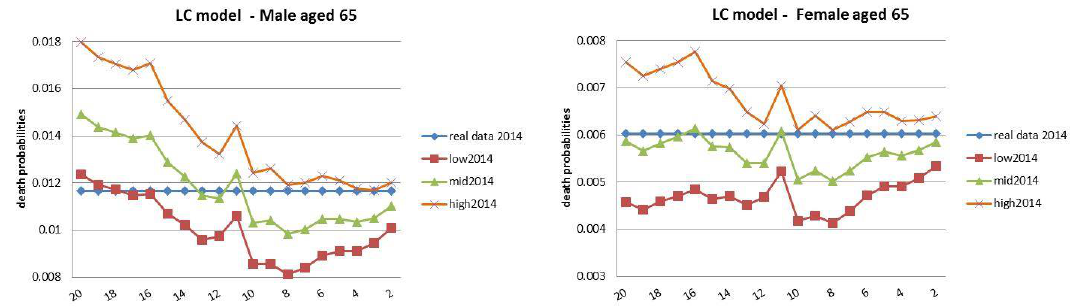
Figure 19. LC Rolling Fixed-Length Horizon Backtests (age 65): convergence to real data (2014).